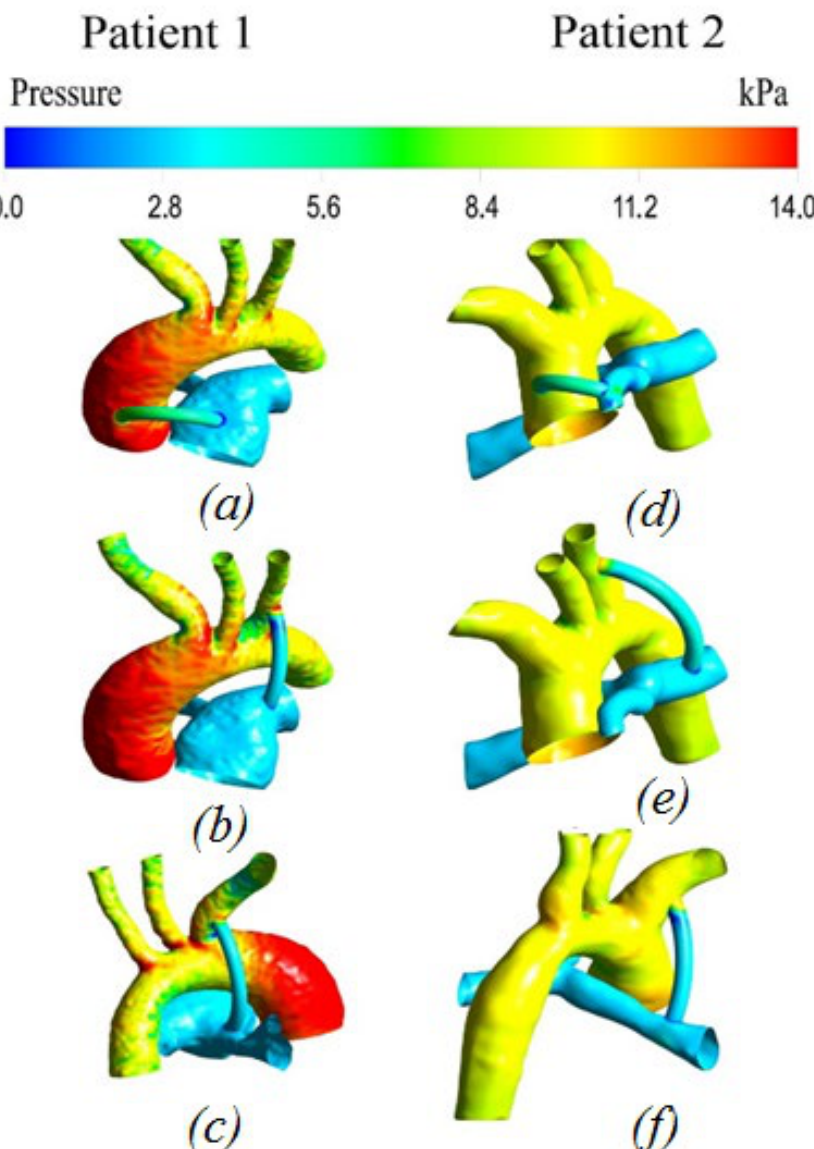
Figure 7. Pressure distribution with anisotropic properties of the aorta and hyperelastic properties the shunt: ( a , d ) central shunt; ( b , e ) right shunt; ( c , f ) left of the shunt: ( a , d ) central shunt; ( b , e ) right shunt; ( c , f ) left shunt.